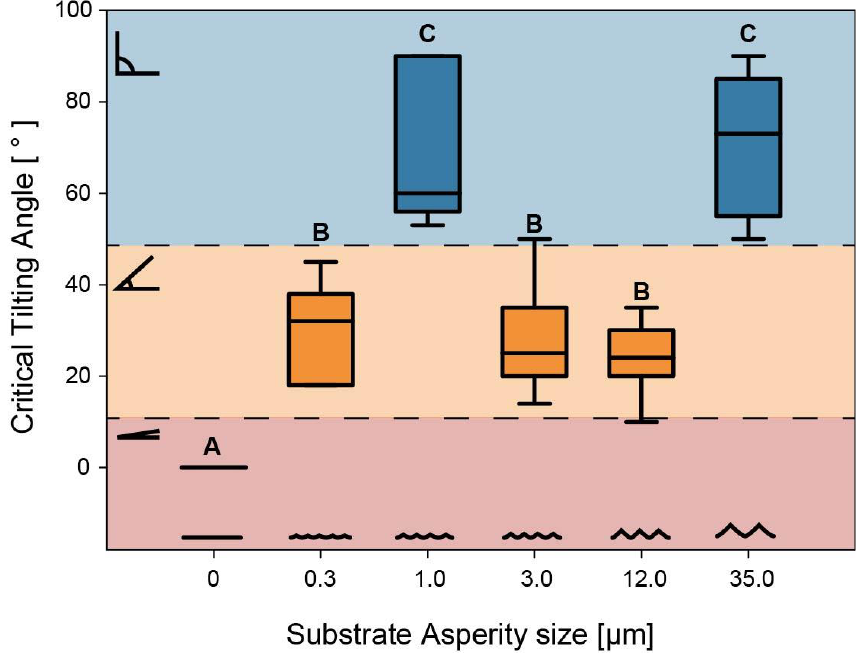
Figure 6. Attachment performance. Boxplots showing the critical tilting angles, at which the individuals started to slide during the substrate tilting experiments. Letters indicate statistical differences. Different letters are significantly different from each other (ANOVA on ranks, Holm-Sidak post hoc test p < 0.05).